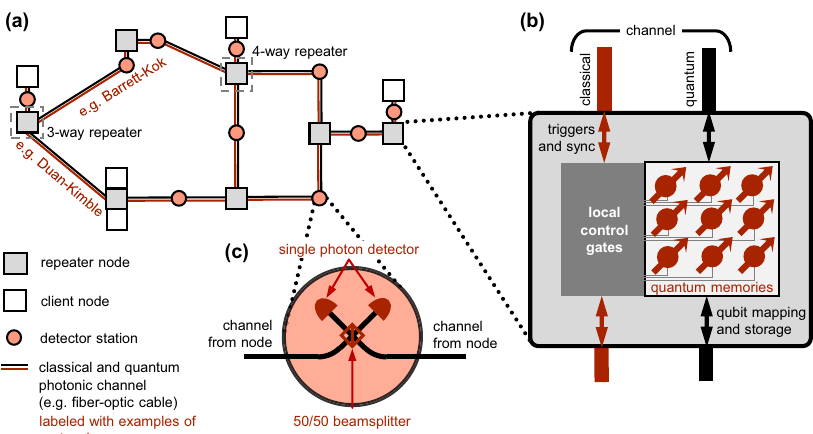
Fig. 1 Components of a quantum repeater network. The quantum network comprises client nodes, which end users directly access, and repeater nodes, which connect clients by propagating entanglement through the network. a Physical layer implementation. In the physical layer 4 , repeater nodes may be connected by a variety of entanglement protocols. While all protocols require transmission of an entangled photon through a photonic channel, the speci fi c protocol used in each link determines the physical con fi guration of these channels (e.g. optical fi bers) and measurement devices associated with that link. Possible protocols include the cavity-mediated Duan – Kimble protocol 9 and the photon emission-based Barrett – Kok 5 and Cabrillo 6 protocols. These latter protocols employ an intermediate detector station between nodes to herald successful entanglement. b Components in a repeater node. We classify repeater nodes based on the number of other nodes they connect to: a 4-way and a 3-way repeater are labeled. All adjacent repeater nodes are connected by quantum and classical channels (shown explicitly in black and light red respectively). c Detector station used in the photon emission-based protocols to herald